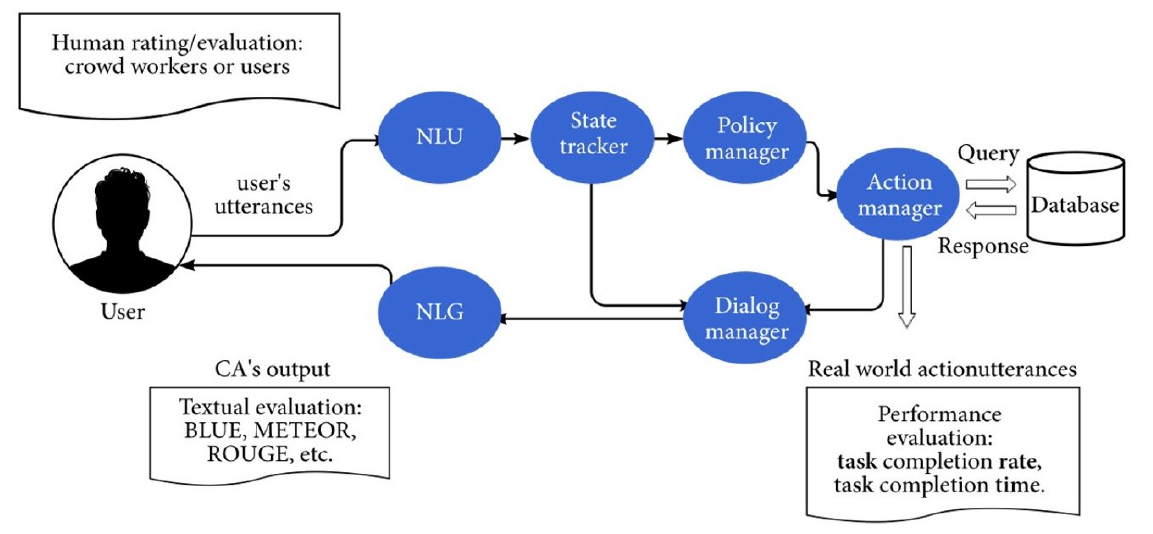
Figure 10. A diagram illustrating the various CA evaluation